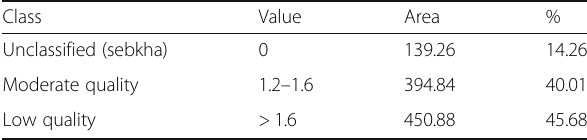
Table 11 Spatial distribution of vegetation quality index classes